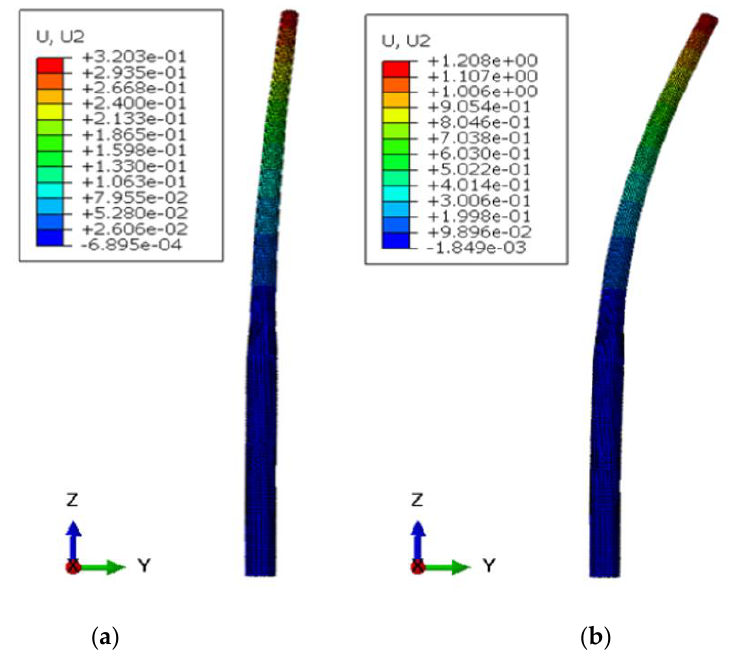
Figure 10. Lateral displacement: ( a ) Normal conditions, ( b ) Extreme sea state.